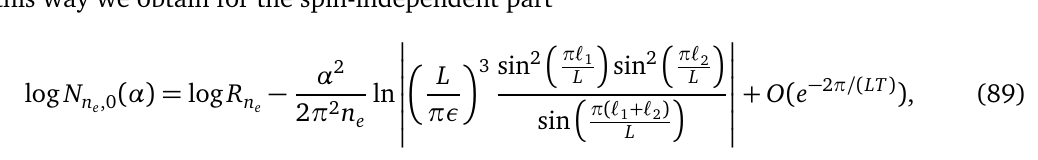
obtained in the replica limit as n it is different from n